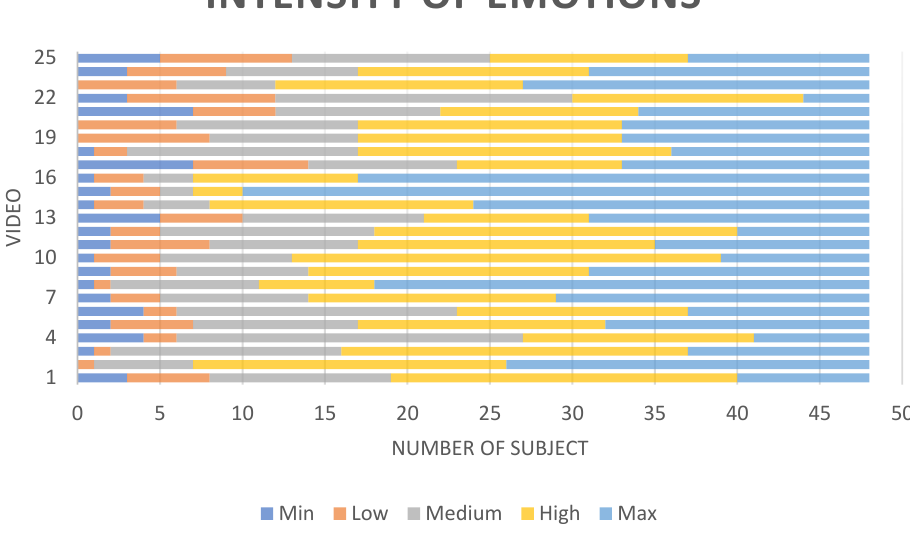
Figure 7. Intensity of the emotions rated by the subjects for each video, except neutral.